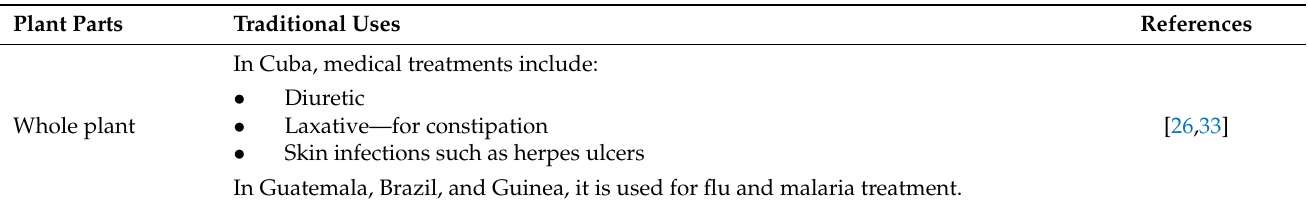
Table 2. Ethnomedicinal uses of Cassia alata